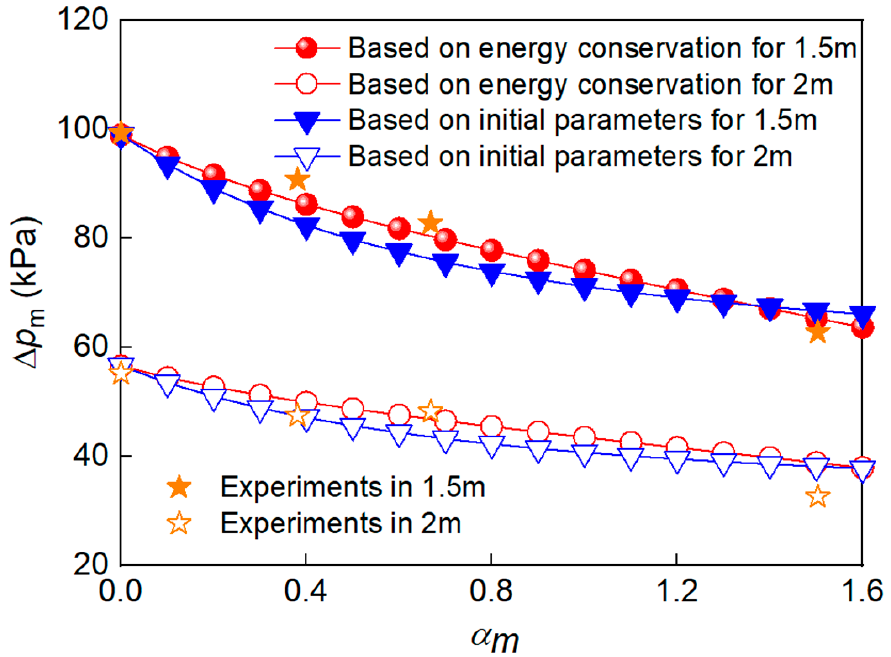
Figure 10. Comparison between Δ p m values for different α m values in the theoretical calculation and experimental measurement. Table 5. Comparison between the theoretical calculation and experimental measurement of peak overpressure under different α m [4].